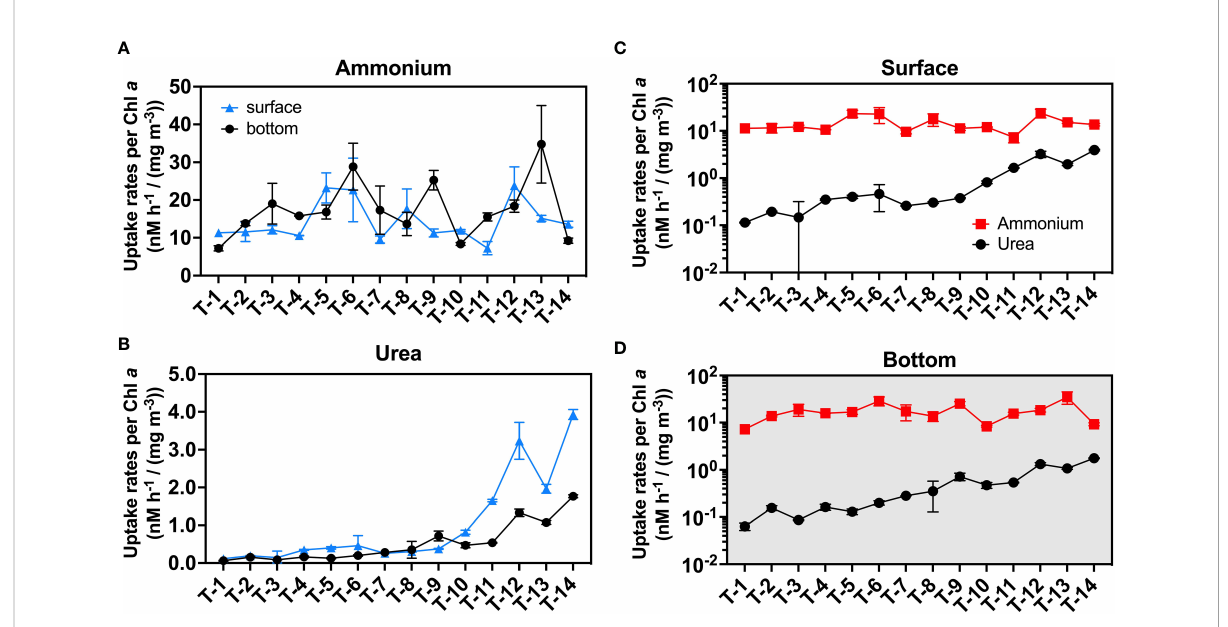
FIGURE 5 The uptake rate normalizes to Chl a . Sub fi gure (A) is plotted for the ammonium uptake rate while (B) is plotted for the urea uptake rate. Sub fi gures (C) and (D) are used for representing the magnitude of the rates in the surface (C) and bottom (D) layers. Blue triangles indicate surface rates, and black circles indicate bottom rates in sub fi gures (A, B) ; red squares and black circles represent normalized ammonium and urea uptake rates, respectively in sub fi gures (C, D) . The error bars represent the standard deviation of the two biological